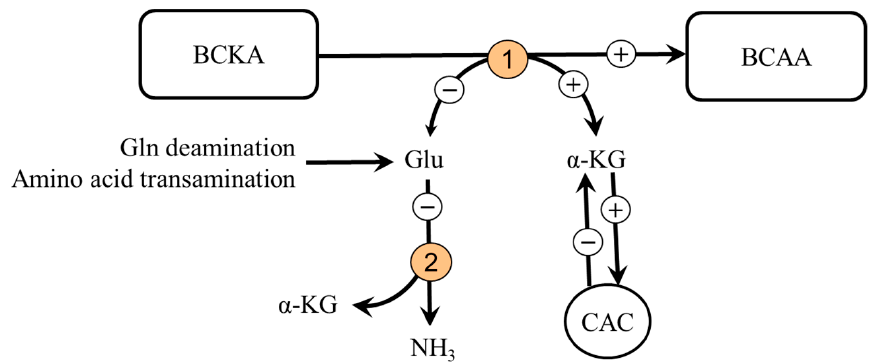
Figure 7. Supposed effects of BCKA supplementation on BCAA and ammonia synthesis. 1, BCAA aminotransferase; 2, glutamate dehydrogenase.